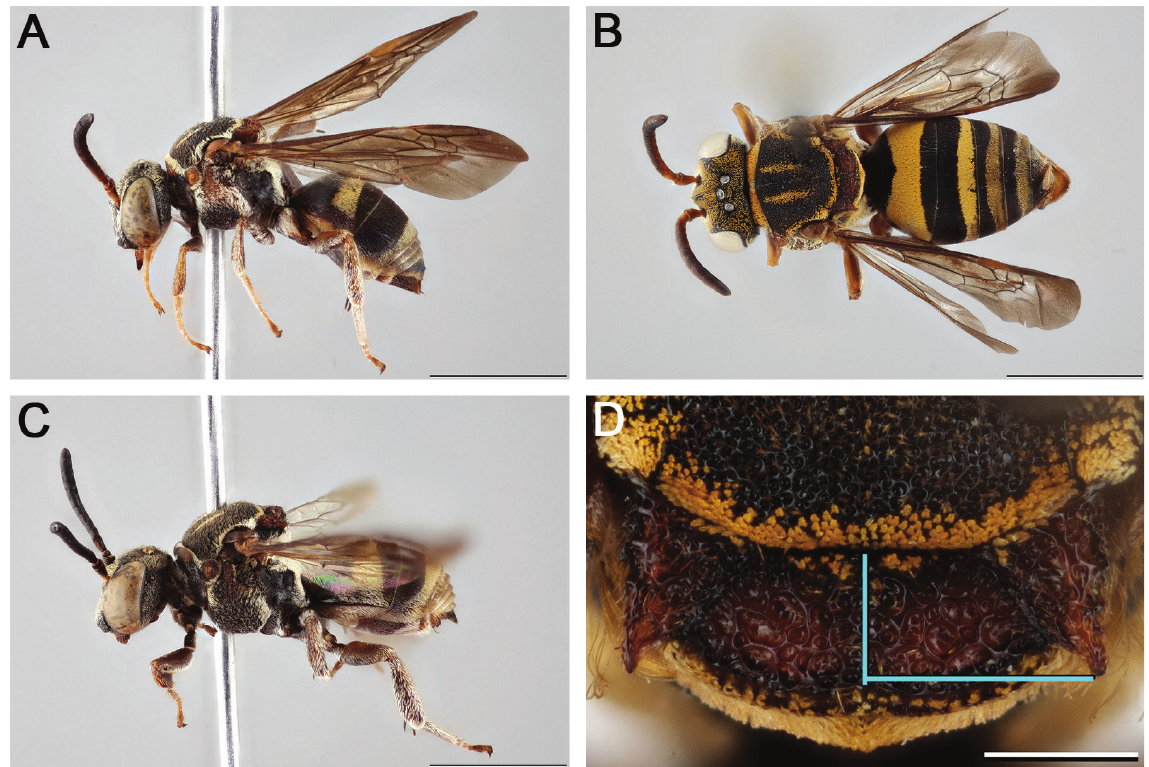
Fig. 11. Epeolus fumipennis Say, 1837. A . Female, habitus, lateral view. B . Female, habitus, dorsal view. C . Male, habitus, lateral view. D . Female axillae and mesoscutellum, dorsal view (blue lines indicate the posterior extent of the axilla relative to the length of the horizontal dorsal portion of the mesoscutellum). Scale bars: A–C = 3 mm; D = 0.5